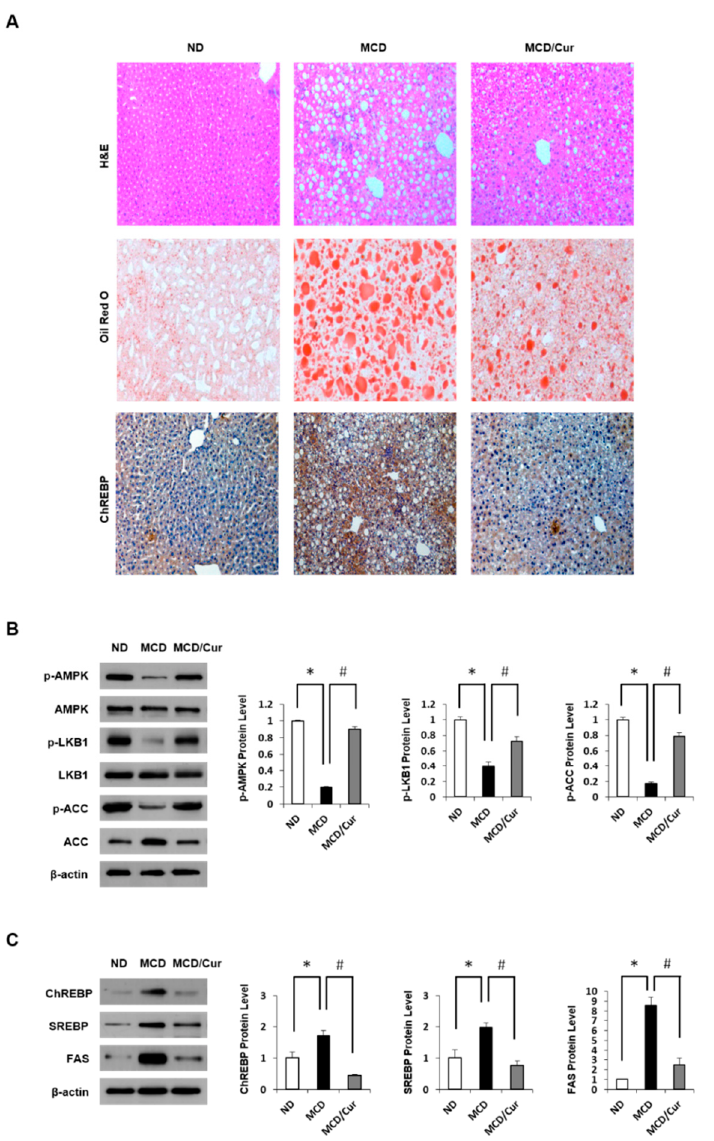
Figure 1. Effect of curcumin on lipid accumulation in methionine and choline-deficient (MCD) diet mice. Mice were fed a normal diet (ND), MCD diet, or MCD/curcumin (100 mg/kg) diet for 3 weeks. ( A ) Representative pictures of liver sections from these groups were assessed by hematoxylin-eosin (H&E) staining, Oil Red O staining, and immunohistochemical (IHC) analysis against carbohydrate response element-binding protein (ChREBP) (original magnification 200×). ( B ) and ( C ), Hepatic expression levels of phosphorylated AMP-activated protein kinase (p-AMPK), phosphorylated Liver kinase B1 (p-LKB1), and phosphorylated Acetyl-CoA carboxylase (p-ACC) along with ChREBP, Sterol regulatory element-binding protein (SREBP) and Fatty acid synthase (FAS) were measured by immunoblot assay. The levels of proteins were normalized to endogenous β -actin protein for each group. Data are mean ± SD ( n = 7/group). * p < 0.05 vs. ND diet group, and # p < 0.05 vs. MCD diet group.